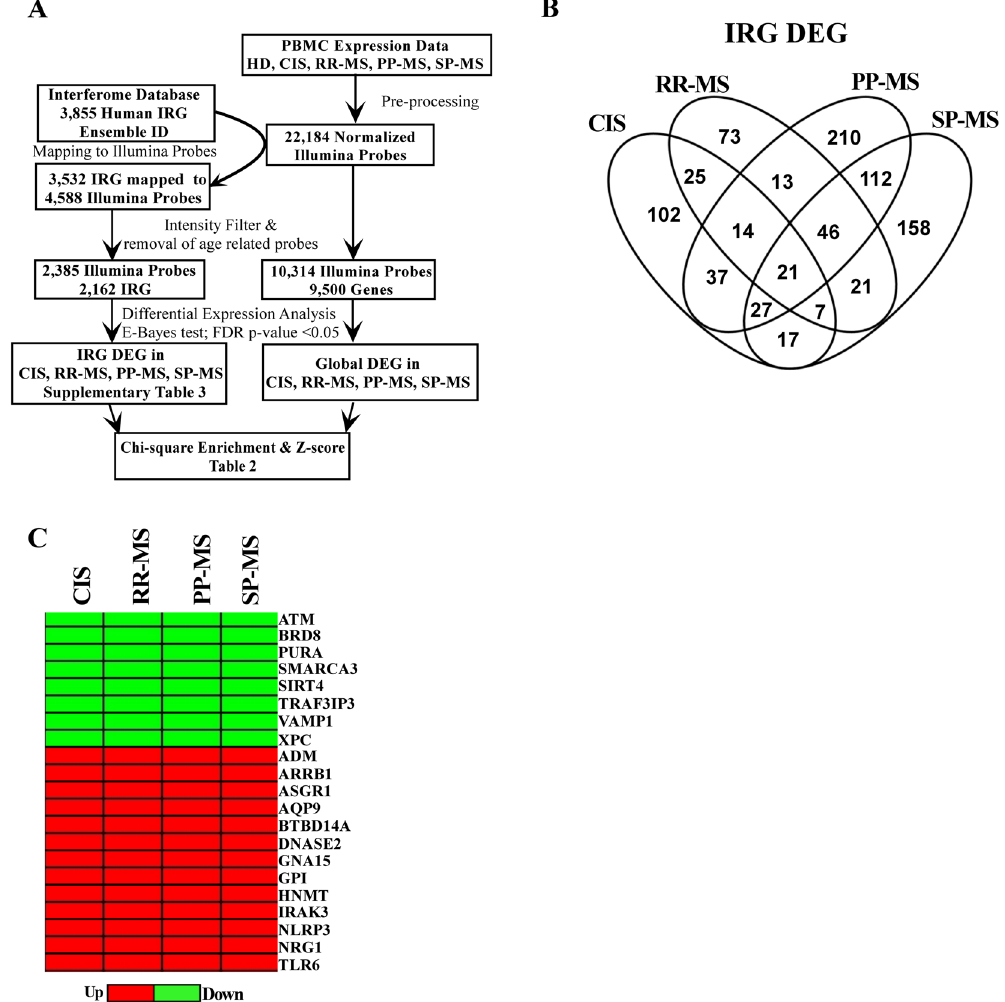
Figure 2. ( A ) Flow chart for the human PBMC transcriptomics study at distinct MS stages. ( B) Number of common and unique IRG DEG for each disease stage. ( C ) Fold change heatmap representing significantly upregulated (red color) or down regulated (green color) IRG at distinct MS stages compared to healthy subjects.